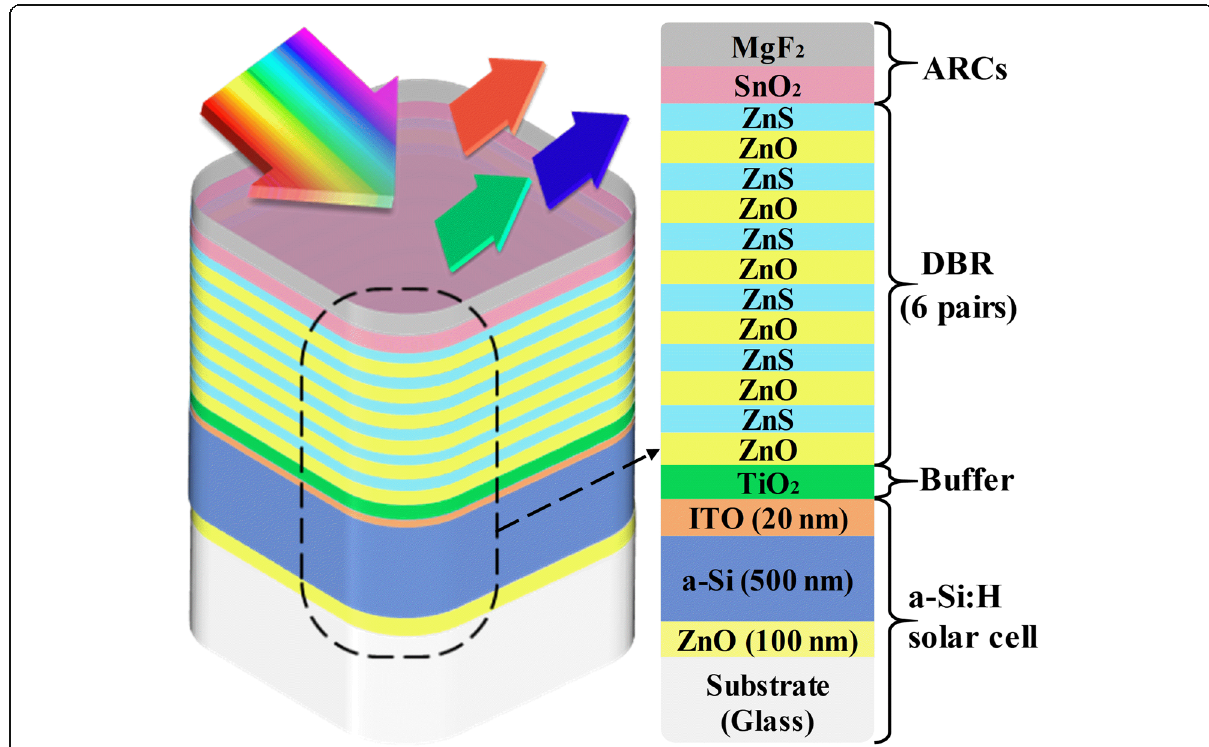
Fig. 1 Schematic diagram of the proposed color-controlled a-Si:H SCs (left) and the detailed device configuration